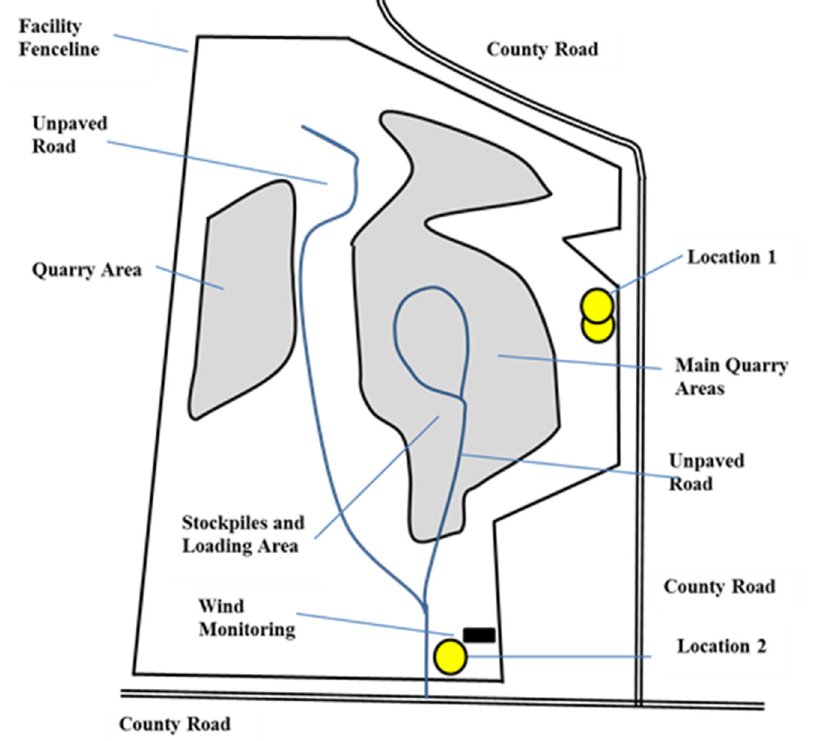
Figure 5. S&S Mine sampler locations.